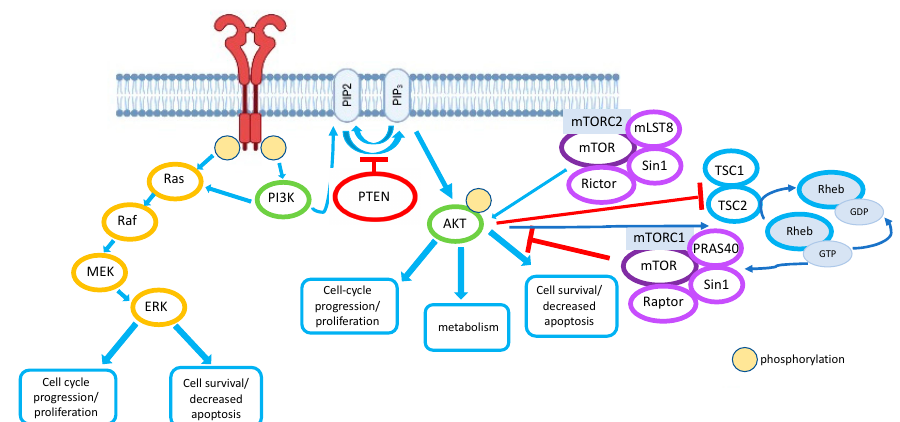
Figure 1. Schematic of the canonical PI3K/AKT signaling pathway. Light blue arrows denote the activating signal transduction events between the members of a particular pathway (shown as circles of different color). Red crossbars denote the inhibitory events. Upon activation of RTK (receptor tyrosine kinase), PI3K (phosphatidylinositol 3-kinase) phosphorylates and produces PIP3 (phos- phatidylinositol (3,4,5)) from PIP2 (phosphatidylinositol (4,5) bisphosphate). PTEN (phosphatase) promotes the reverse reaction thus negatively regulates the pathway. PIP3 facilitates the phospho- rylation of AKT (protein kinase B). Activating AKT phosphorylates different target proteins and mediates multiple cellular events and processes such as cell cycle, metabolism, survival, apoptosis, etc. Schematic representation of an alternative non-AKT-dependent activation pathway via the Ras/MAPK signaling. Upon exposure of cancer cells to extracellular signals sensed by RTKs, the signal is transferred via the Grb2/SOS protein complex to specific receptor(s) rat sarcoma virus (Ras), which binds GTP and recruits a protein kinase, rapidly accelerated fibrosarcoma (Raf). The latter relays the signal to another kinase, mitogen-activated protein kinase kinase (MEK), followed by the transfer to yet another kinase, extracellular signal-regulated kinase (ERK). ERK mediates a variety of cellular events via phosphorylation of a number of transcription factors (cell cycle, survival, apoptosis, etc.). AKT phosphorylates TSC2, which forms a functional complex with TSC1. Phosphorylation of TSC2 impairs the ability of the TSC1-TSC2 complex to act as a GAP toward the small GTPase Rheb. Rheb-GTP potently activates mTORC1. Phosphorylation of PRAS40 by Akt and by mTORC1 itself results in dissociation of PRAS40 from mTORC1 and may relieve an inhibitory constraint on mTORC1 activity. Only the key upstream phosphorylation events are shown.